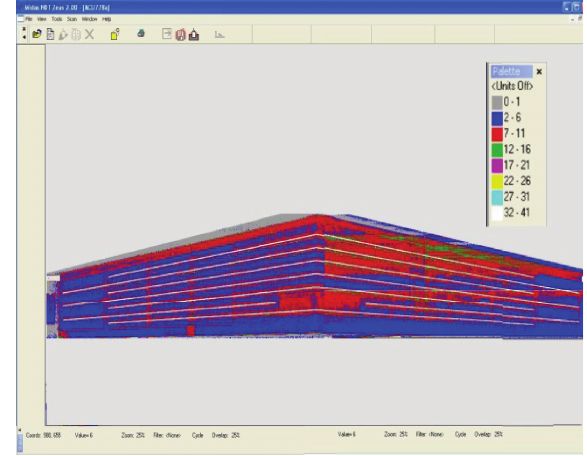
Figure 15: Screenshot of results of C-scan test conducted on HT of SARAS